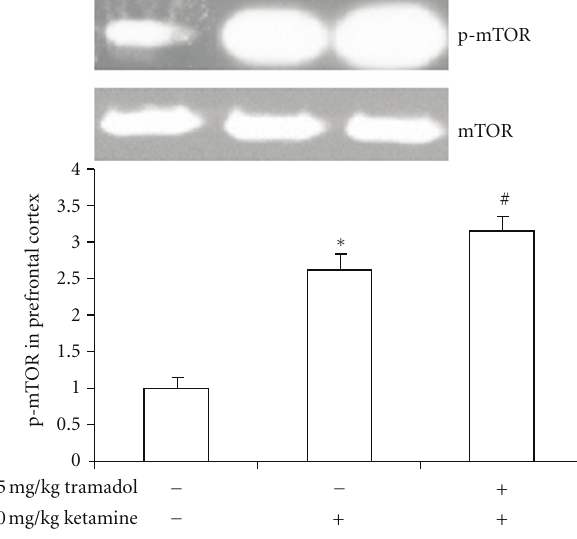
Figure 5: The expression of p-mTOR in rat prefrontal cortex ( n = 3). Ketamine administered at the 10mg/kg significantly increased the expression of p-mTOR in rat prefrontal cortex as compared with control ( ∗ P < 0 . 05), and tramadol pretreated at the dose of 5mg/kg significantly increased the expression of p-mTOR as compared with ketamine administered alone ( # P < 0 .